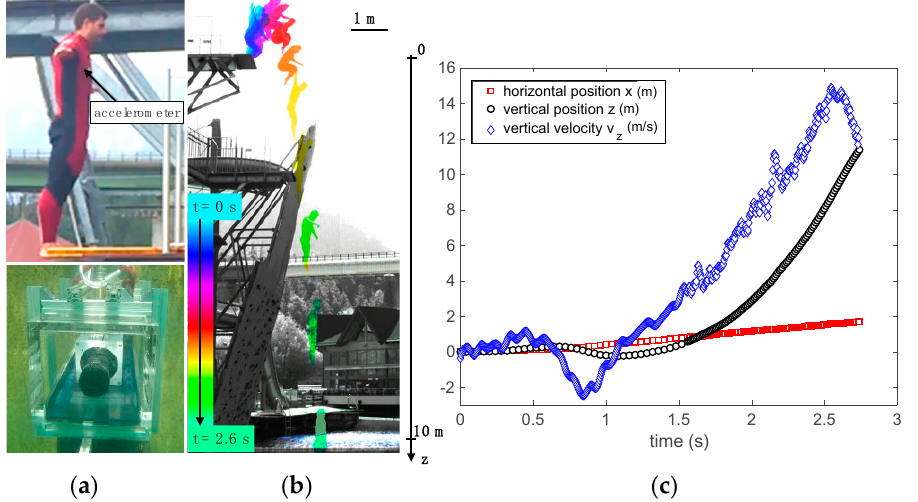
Figure 1. ( a ) Experimental setup: an accelerometer is inserted in the suit of the diver (top), and a high- speed camera is immersed at 3-m deep in a waterproof box to record the underwater trajectory (bottom); ( b ) Colored chronophotograph of the jump: time elapses from light blue to green, with a timestep of 0.2 s between two images; ( c ) Evolution of the horizontal (x) and vertical downward (z) positions and vertical velocity (v z ) in function of time. The origins of time and positions are taken at the beginning of the jump for the aerial